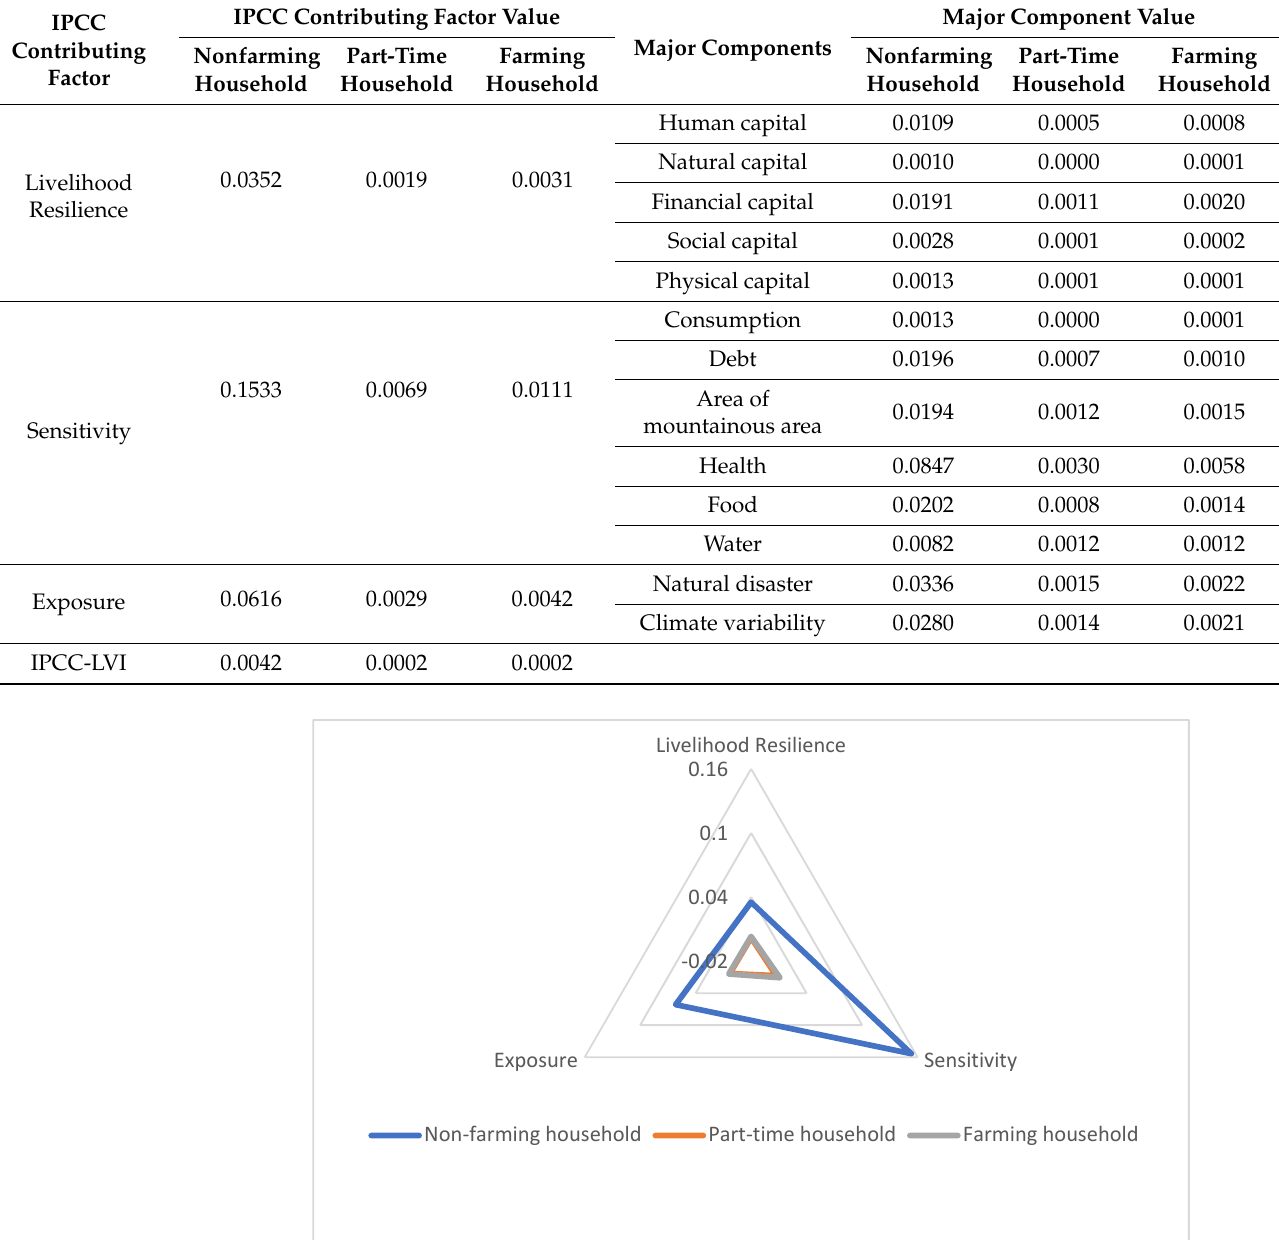
Table 4. Livelihood vulnerability index of different livelihood strategies. (Source: the author, 2021).